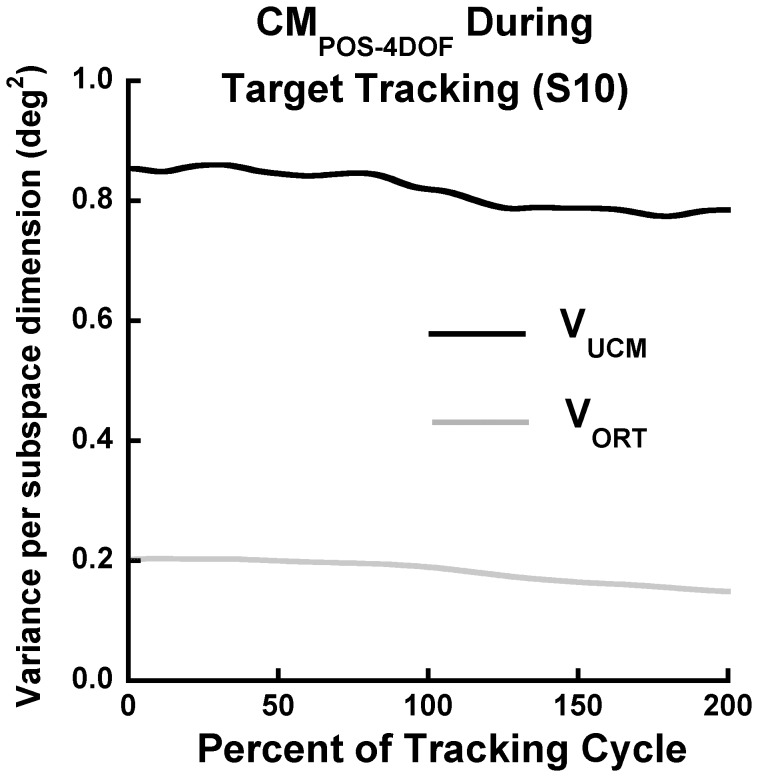
Example of components of joint configuration variance across the tracking cycle.Components of joint configuration variance per dimension of joint subspace (deg2) across the tracking cycle, related to stability of the 4-DOF CM position of a representative subject. Note the consistency of VUCM and VORT across the cycle, leading to using the average across the cycle for further statistical analyses.